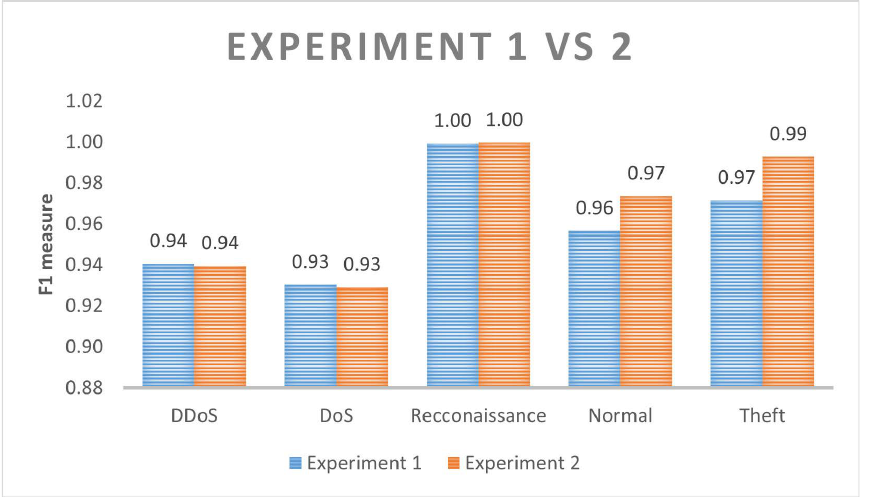
Figure 6. Random forest results after CTGAN